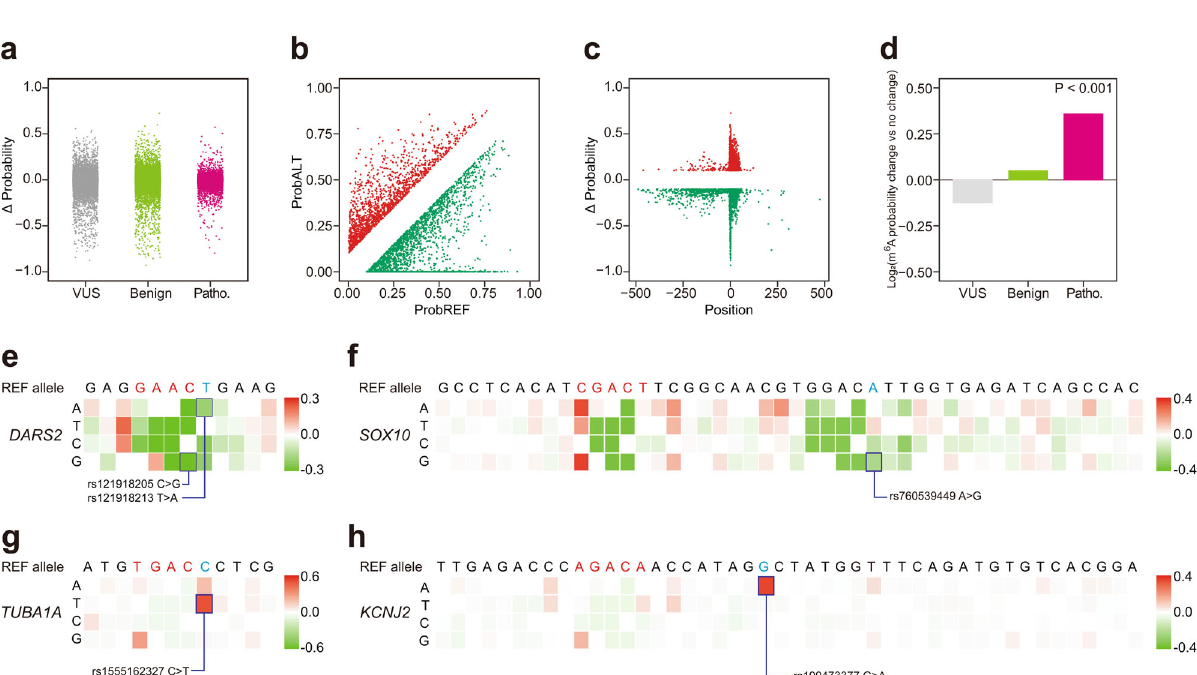
Fig. 4 Many pathogenic SNVs are associated with m 6 A deposition changes. a Strip plot of Δ Probability caused by SNVs, which were categorized by clinical signi fi cance in ClinVar. VUS means uncertain signi fi cance SNVs (gray), Benign means benign and likely benign SNVs (green), and Patho. means pathogenic and likely pathogenic SNVs (pink). b Scatter plot of modeled probability for m 6 A sites with major allele (ProbREF) or minor allele (ProbALT). Red color dots were mutational events that increased m 6 A probability ( Δ Probability ≥ 0.1); Green color dots are mutational events that decreased m 6